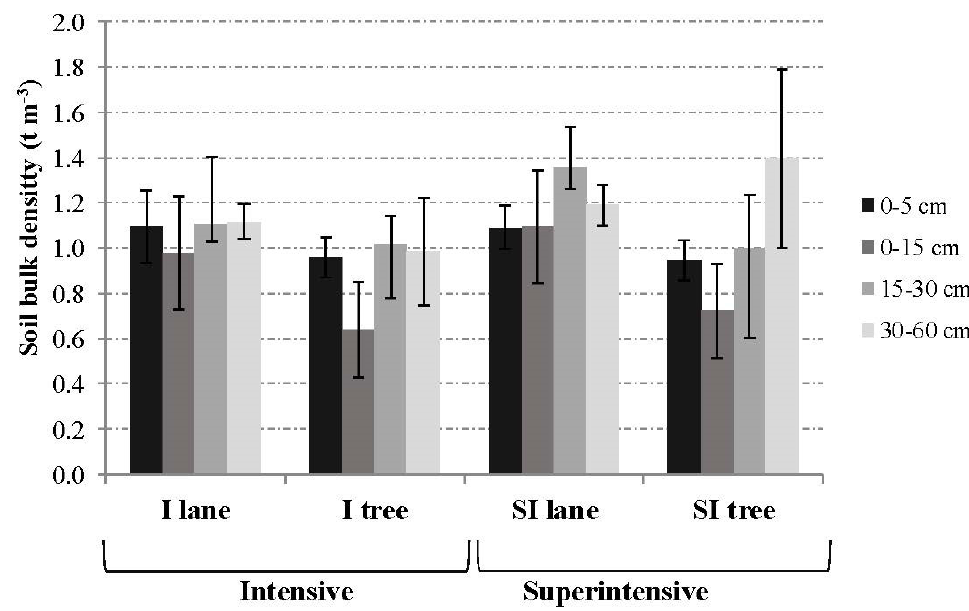
Figure 3. Soil bulk density by depth and location (lane and tree) within the orchard for the two sampled olive orchards (I: intensive; SI: superintensive). Error bars are standard deviation, n = 8. Figure 2B summarizes the SOCstock by depth and location in both olive orchards.